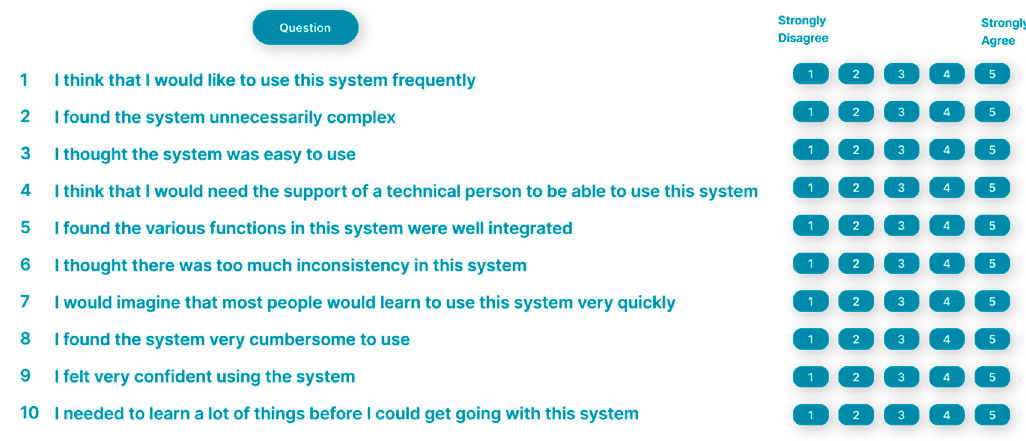
Figure 4. Items of the system usability scale. Adapted from [20].